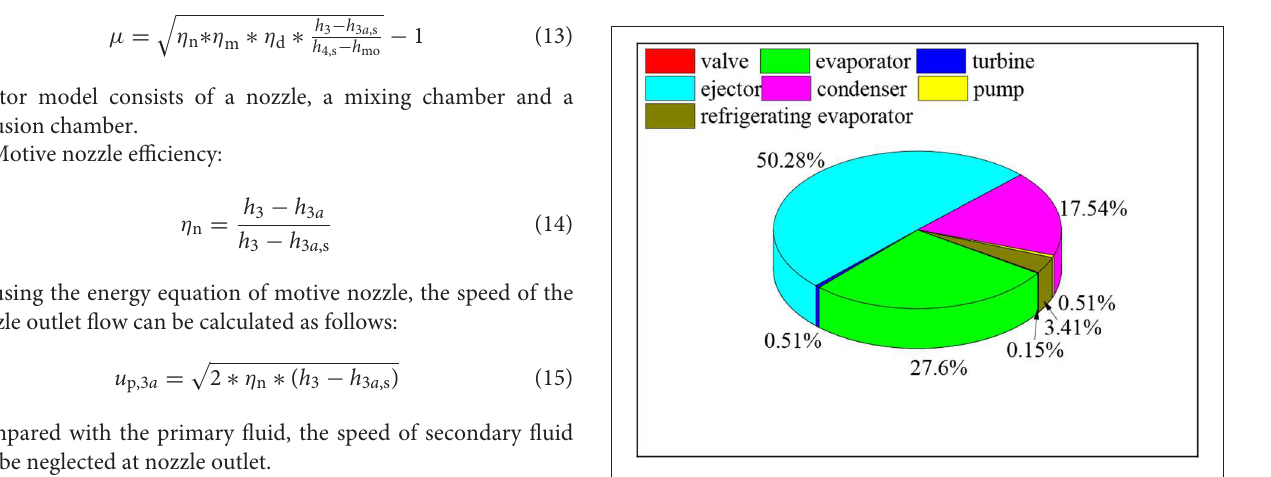
FIGURE 3 | Exergy destruction distribution of equipment in the combined